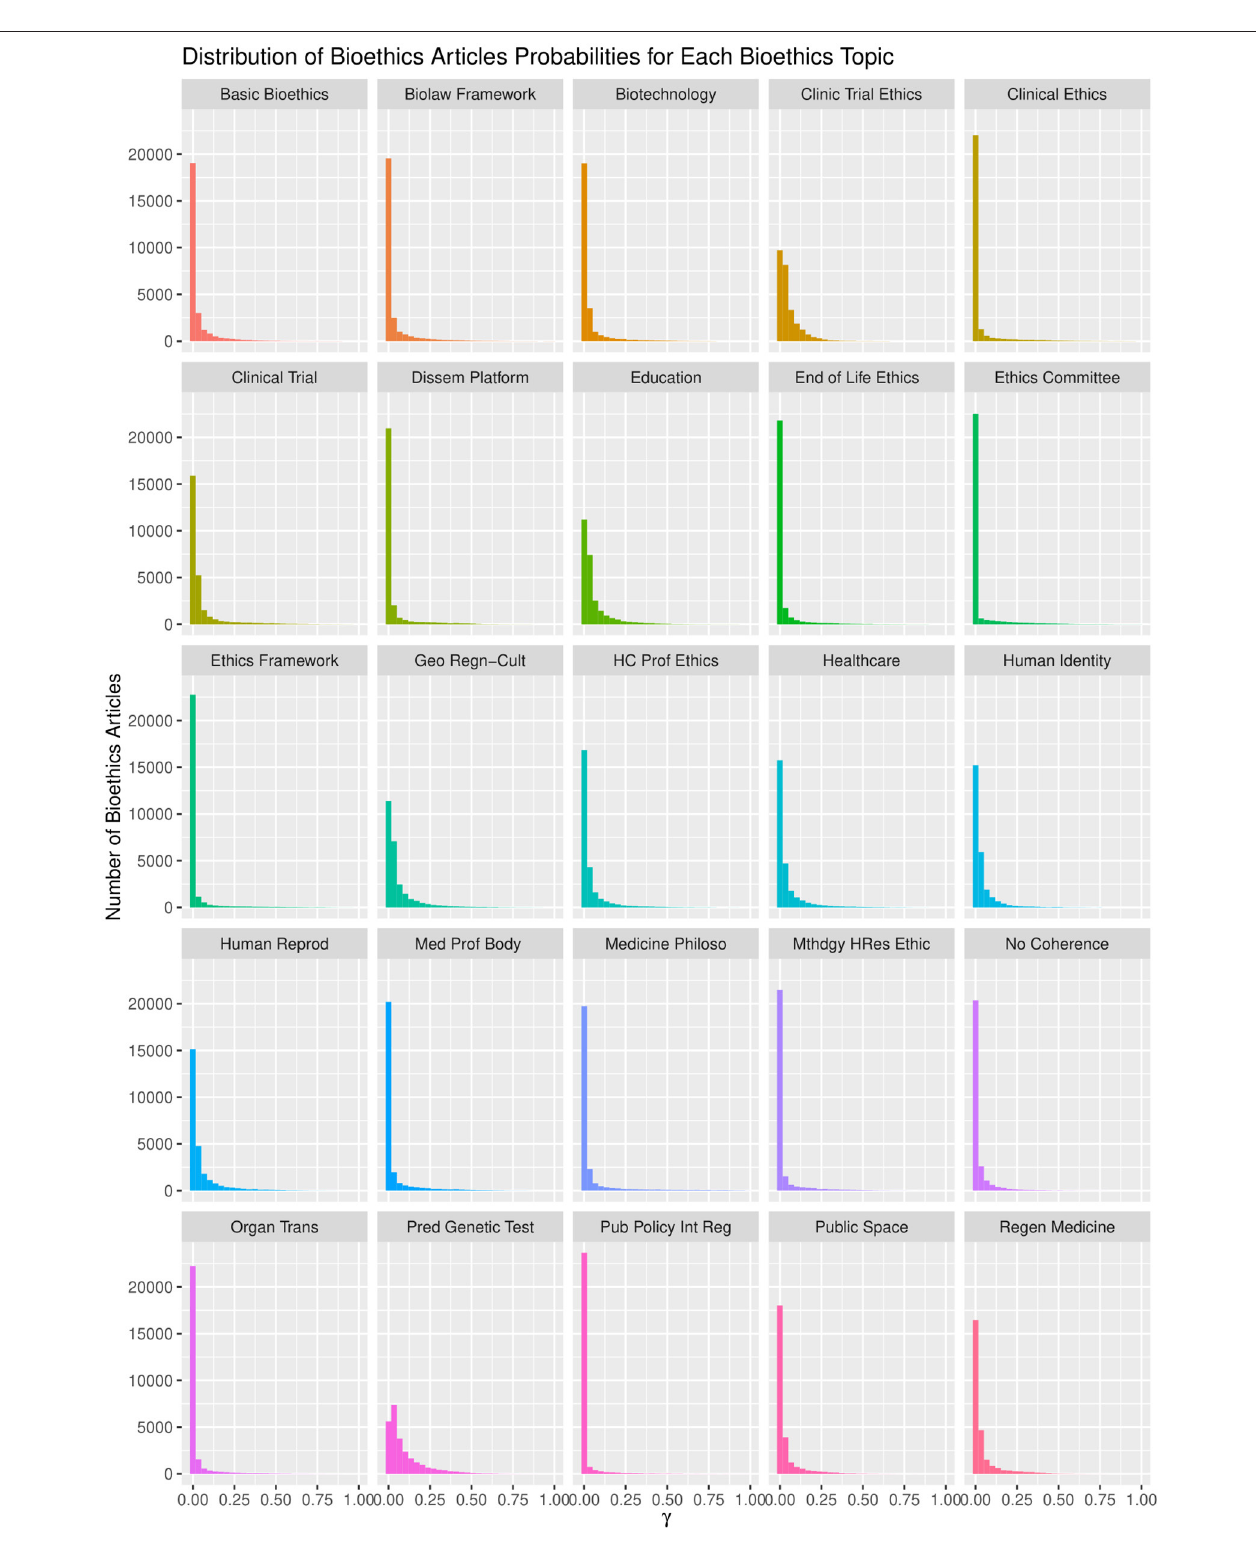
FIGURE 4 | The 25 topics model and their associated information.